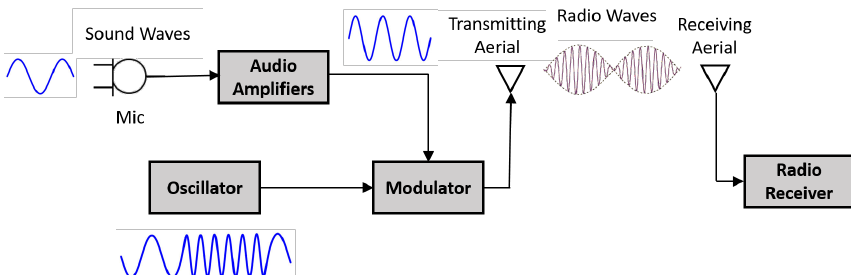
Figure 2. General principle of radio transmission [53].